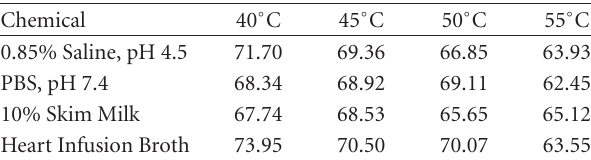
Table 6: Δ S (Entropy of Activation) of Fowlpox virus in various solutions at 40, 45, 50 and 55 ◦ C. Values reported in Calories per mol per degree